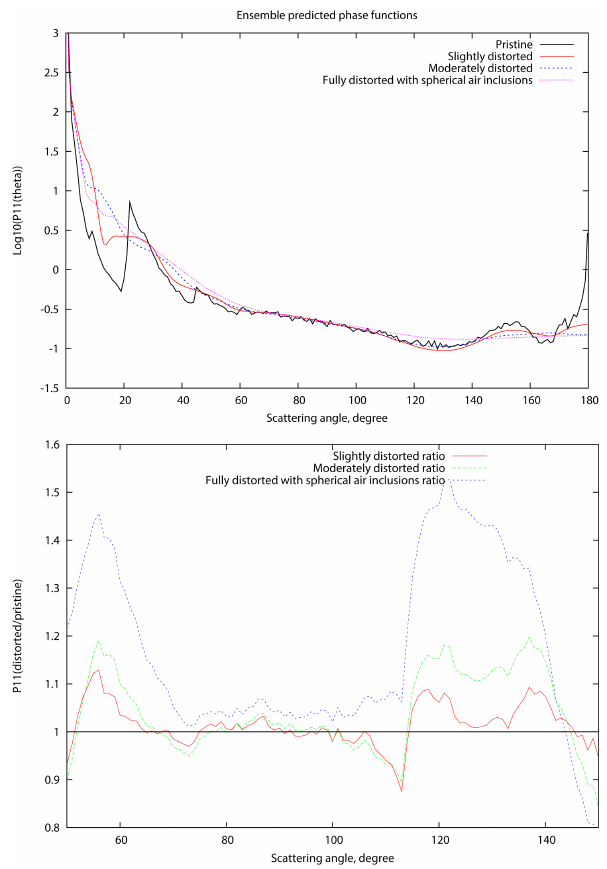
Figure 4. (a) The decadal logarithm of the ensemble model nor- malised scattering phase function as a function of scattering an- gle assuming a variety of distortions. The model cases shown are the pristine (black), slightly distorted (red), moderately distorted (dashed blue) and fully distorted with spherical air bubble inclu- sions (dotted purple). (b) The ratio between the distorted and pris- tine ensemble model phase functions as a function of scattering an- gle. Shown here are slight distortion (red), moderate distortion (dot- ted green) and full with spherical air bubble inclusions (dotted blue). The key is shown in each of the